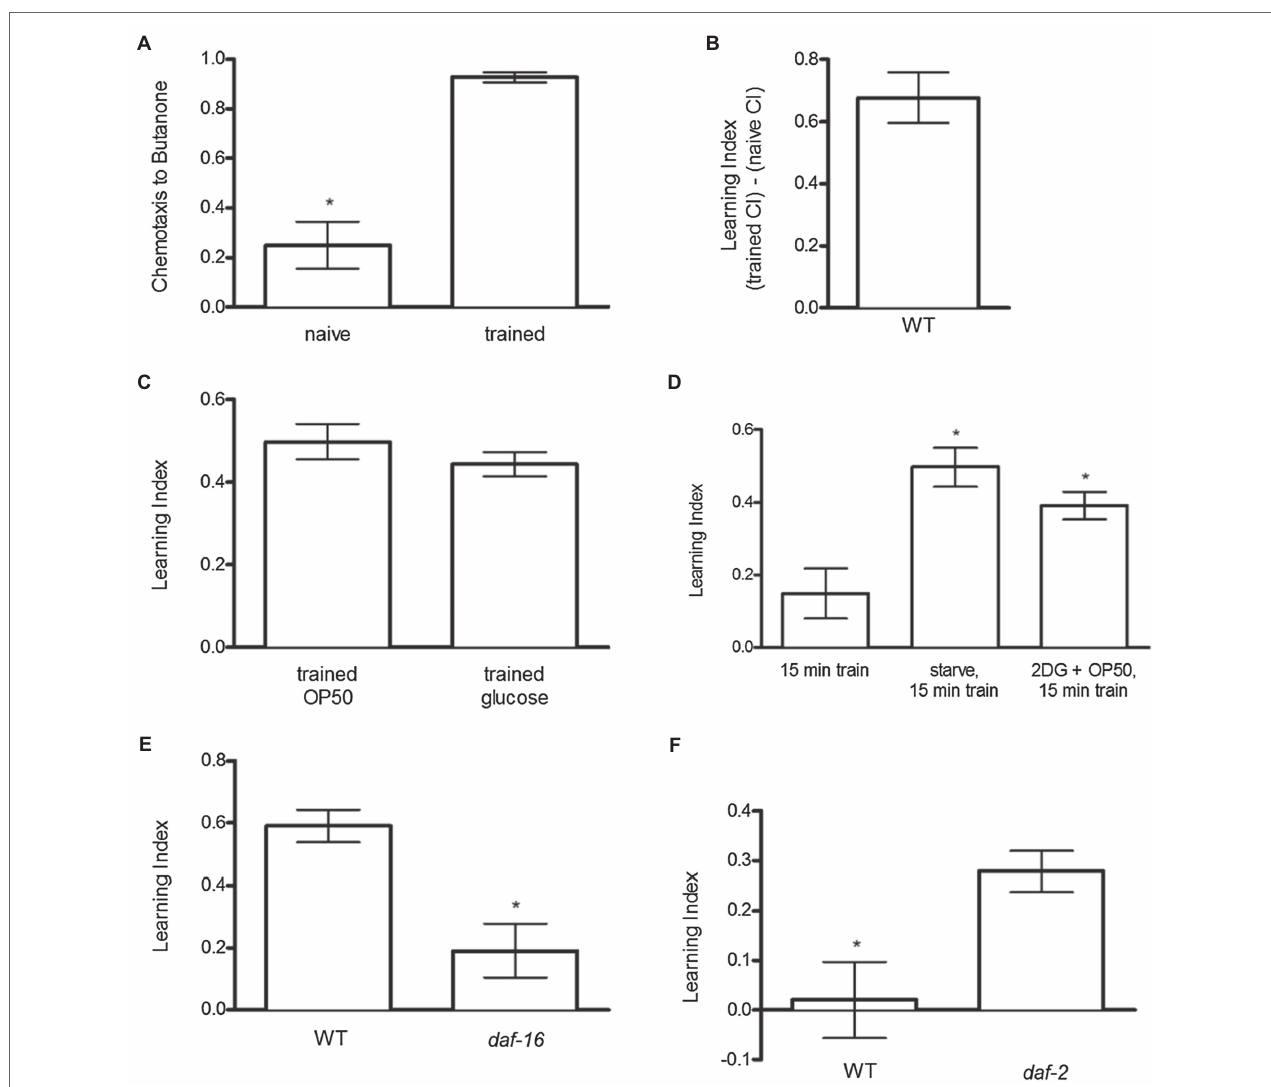
FIGURE 1 | Odor preference development in C. elegans . (A) During training animals learned to associate a rewarding stimulus (food) with a novel stimulus (butanone). Chemotaxis to butanone was measured before (naïve) and after (trained) training. (B) The difference in chemotaxis to butanone before and after training is called the Learning Index (LI); LI = (trained CI) − (naïve CI). (C) Glucose increased odor preference similar to OP50. (D) Food-induced odor preference was similarly enhanced by preceding training with either a pre-fast or by blocking glucose metabolism with 2DG. (E) daf-16 mutant worms decreased odor preference development after training compared to N2 animals. (F) daf-2 worms increased odor preference development compared to N2 animals after a modified training protocol during which animals were trained for 15 min without 1-h fast pretreatment, so there was as expected no increase in learning index in wild-type animals, but daf-2 mimicked effects of fasting to increase the LI. * p < 0.05 ( t test). Each column represents at least 4 independent trials, with approximately 50–150 animals tested per